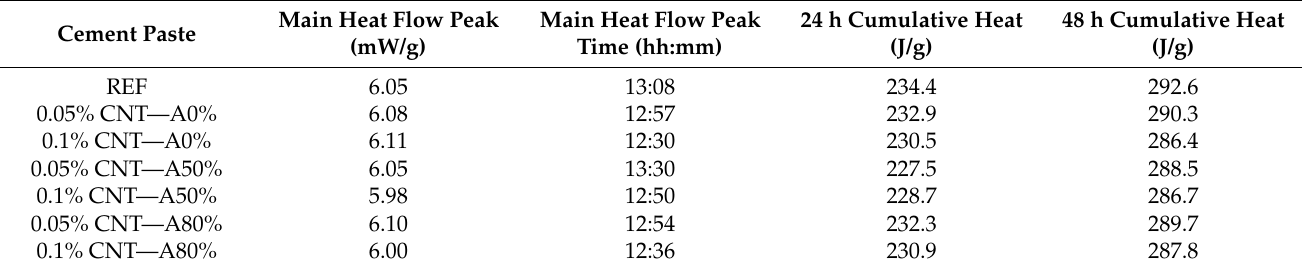
Figure 9. Heat flow ( a ) and cumulative heat ( b ) curves of cement pastes. Table 5. Isothermal calorimetry results.